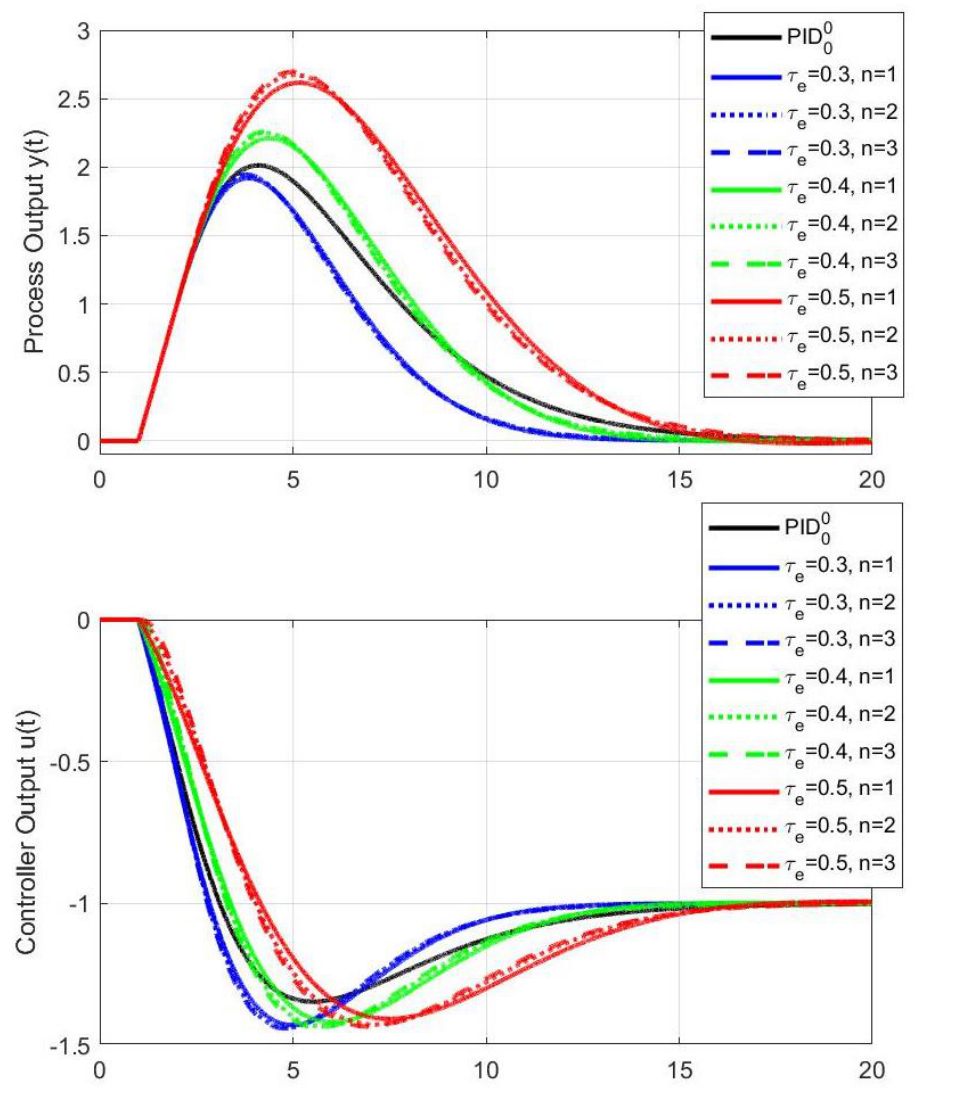
Figure 9. Disturbance responses of the nominal IPDT system with T dp = 1 and K sp = 1 for the unfiltered PI control ( PID 0 ) and PID 1 n controllers with three different values τ e and the T f = T e / n 0 tuning equivalence, n =